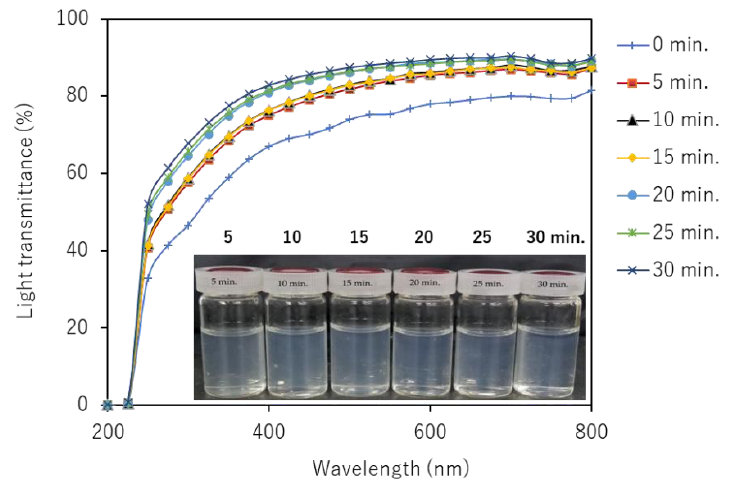
Figure 9. Photographs and UV-Vis transmittance spectra of partially deacetylated chitin nanofiber with respect to ultrasonication time and those photographs.